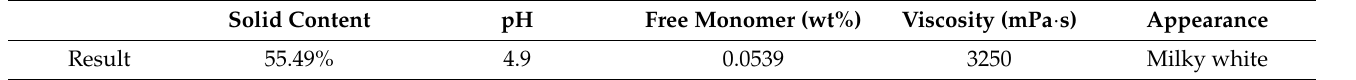
Table 3. Physical and chemical properties of the